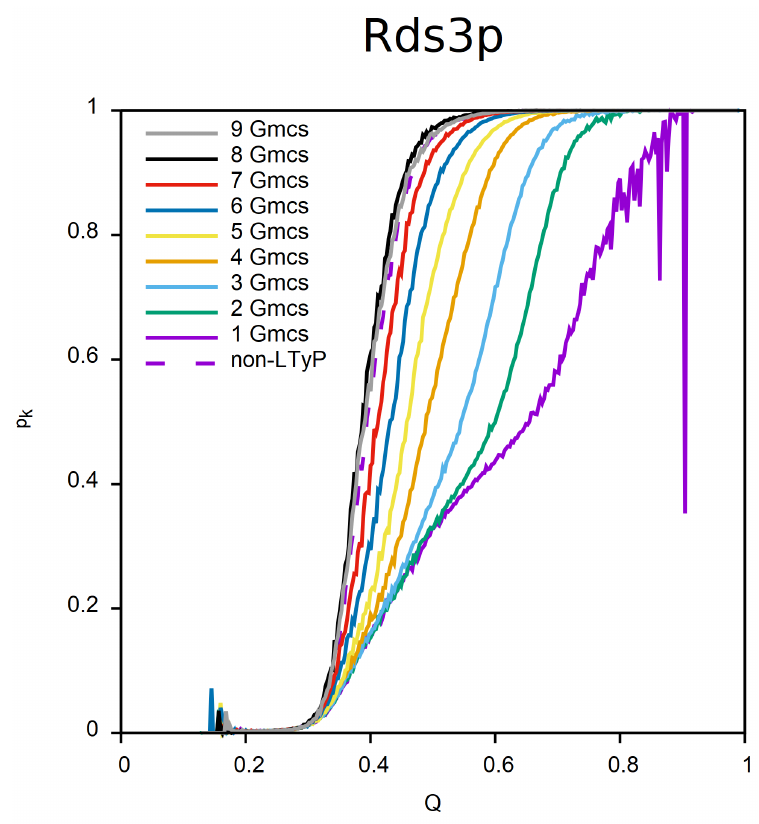
Figure 4. Progress of relaxation for LTyP simulations of protein Rds3p starting from a denatured conformation. Knotting probability, p k , as function of the reaction coordinate, Q , for numbers of relaxation mcs ranging from 10 9 (1 Gmcs) to 9 × 10 9 (9